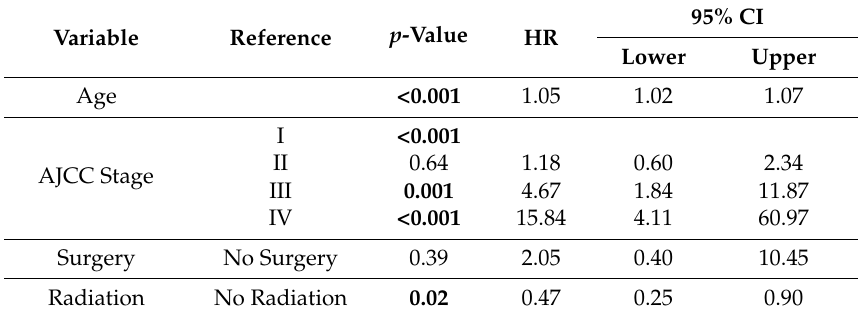
Table 3. Multivariable analysis of overall survival for glycogen-rich clear cell (GRCC.) patients. Variable